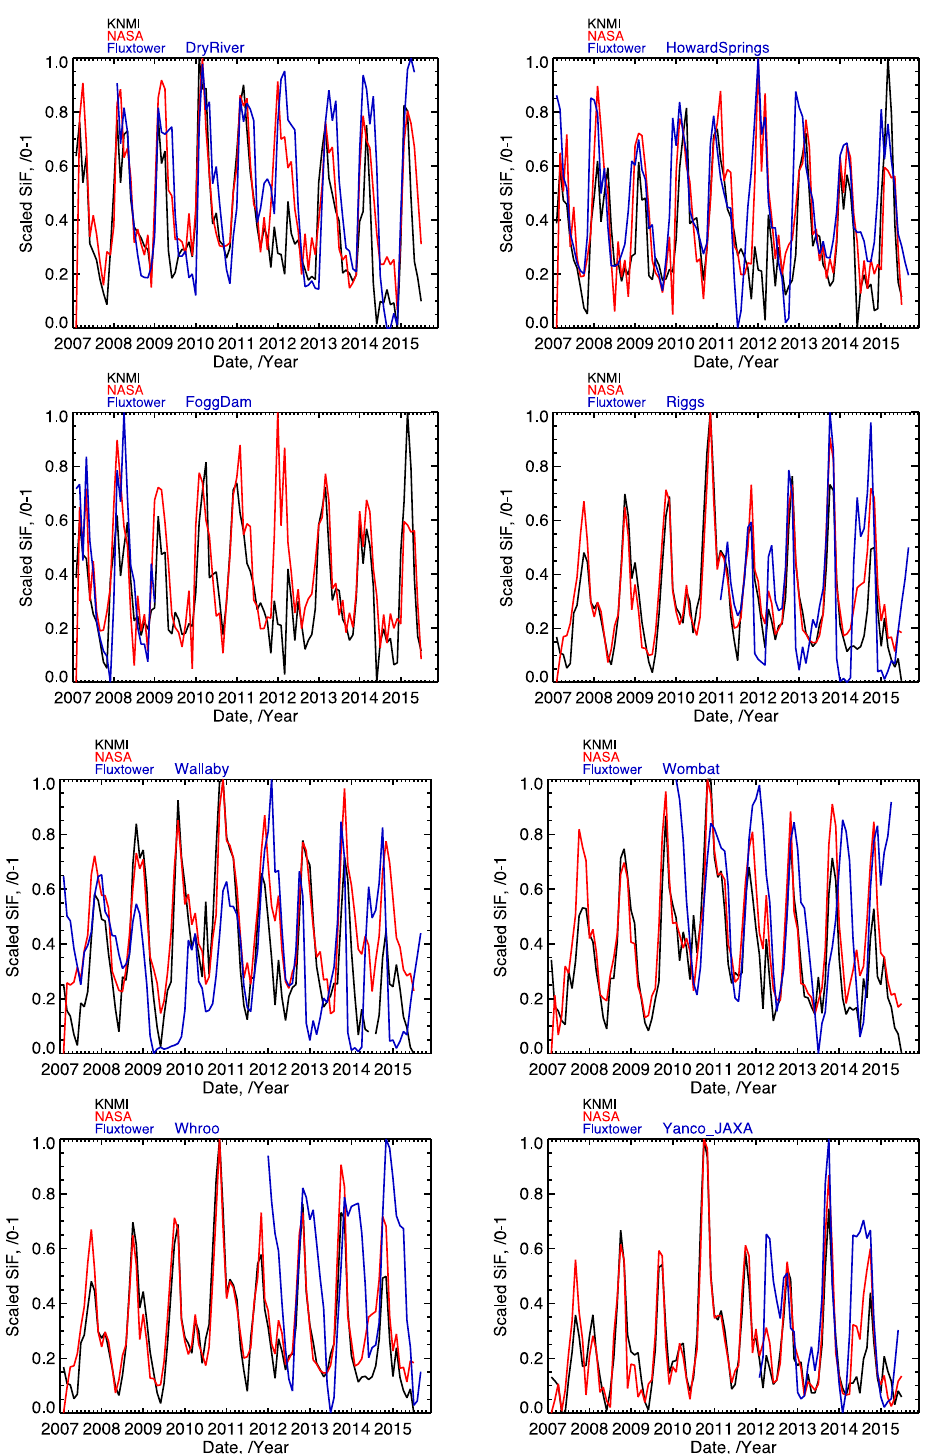
Figure 5. Observed Sun-induced Fluorescence (SiF) time series for January 2007 to June 2015 from the KNMI (black line) and NASA (v26) (red line), and Gross Primary Productivity (GPP) derived from Australian flux towers (blue line). For comparison, the SiF and GPP data sets are scaled to be between zero and one.